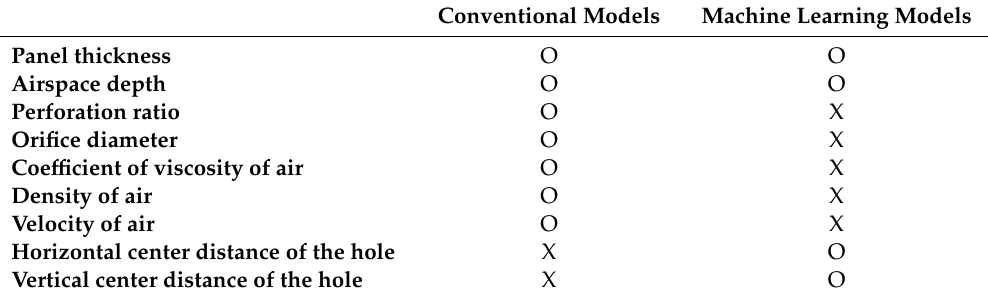
Table 1. Input variables of prediction models (O: necessary; X: